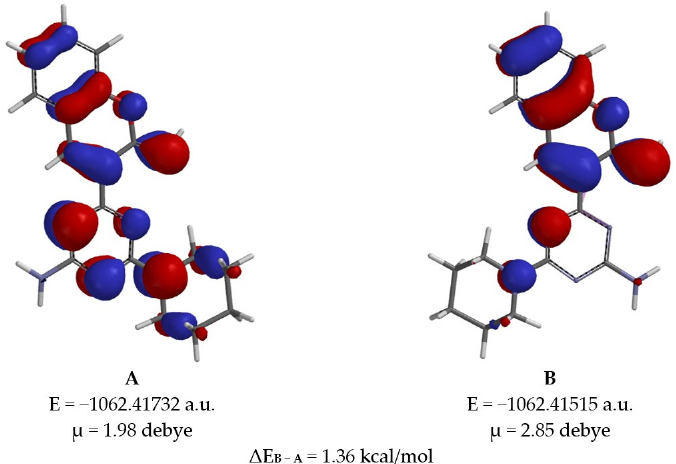
Figure 3. Conformational structures A and B of ligand L1a optimized by density functional method (B3LYP/6-31G*) using Spartan version ‘14 V 1.1.4’. The location of the HOMO orbital is marked in red and blue.